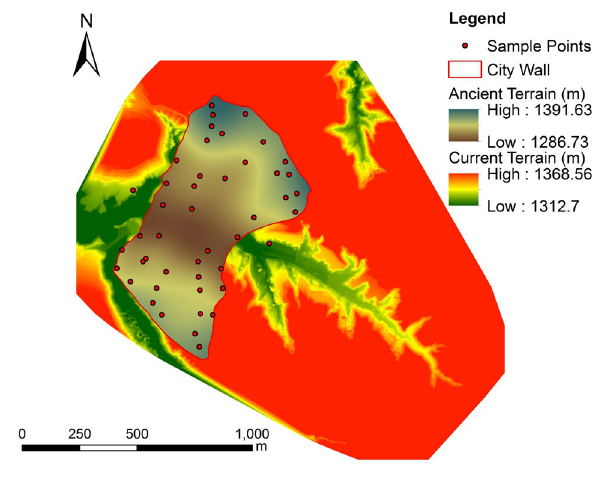
Figure 4. Terrain Model Results. The background is current terrain; above is ancient terrains and sample points used.